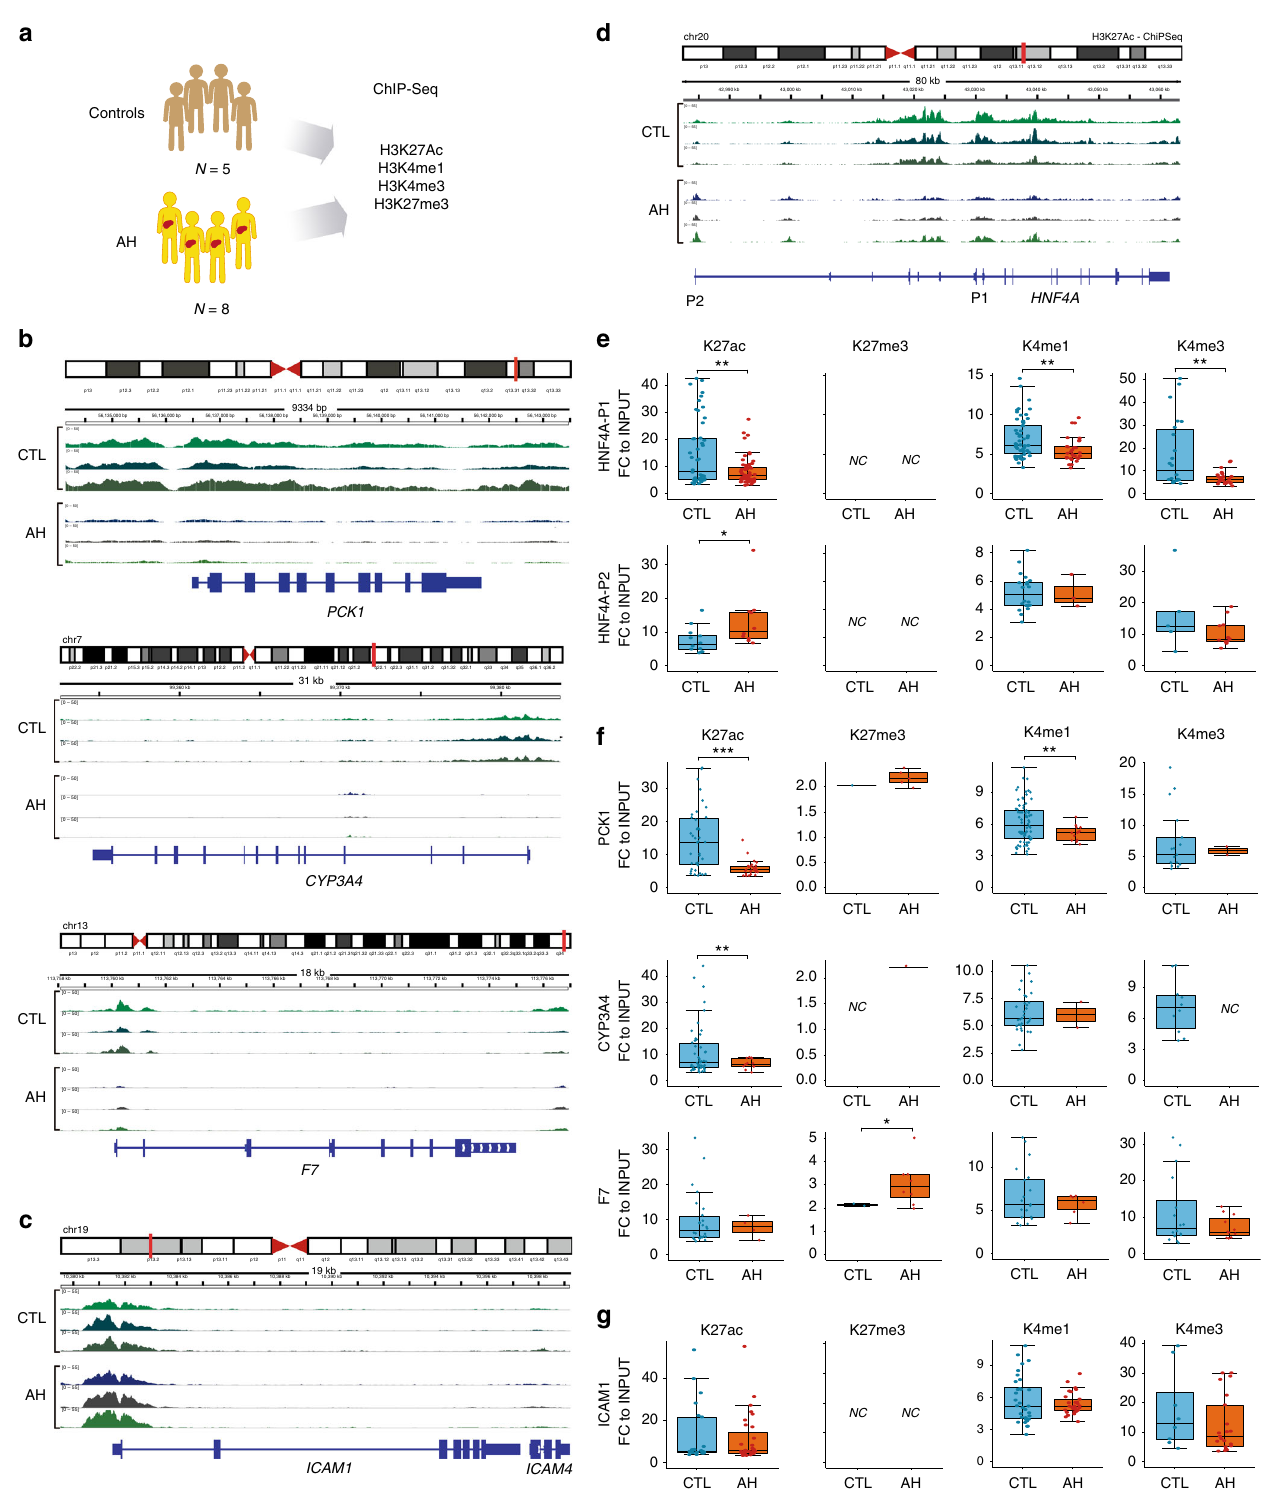
Fig. 10 ChIP-seq shows decreased H3K27Ac and H3K4me1 in HNF4 α -P1 and its targets and enhanced binding of H3K27Ac to HNF4 α P2 promoter. a Data were obtained from ChIP-seq of Human Liver samples from normal ( n = 5) and AH ( n = 6) livers. Antibodies agains Histone 3 Lysine 27 acetylation (H3K27Ac), Histone 3 Lysine 4 mono and trimethylation (H3K4me1 and H3K4me3) and Histone 3 Lysine 27 trimethylation (H3K27me3) were used in the immunoprecipitation. Integrated Genome Viewer was used to visualize BigWig peak data. b – d Genomic view of sequencing reads present in loci of b HNF4 α targets PCK1 , CYP3A4 and F7 , c Non-HNF4 α target ICAM-1 and d HNF4A . e – g Box plot of fold changes (IP to Input) of all peaks called around the TSS of e HNF4A isoforms P1 and P2, f HNF4A targets PCK1 , CYP3A4 and F7 and g ICAM1 . Signi fi cance was determined by two-tailed Student t test in e , f , and g : * P < 0.05, ** P < 0.01, *** P < 0.001. For box-and-whisker plots in e, f, g : perimeters, 25th – 75th percentile; midline,